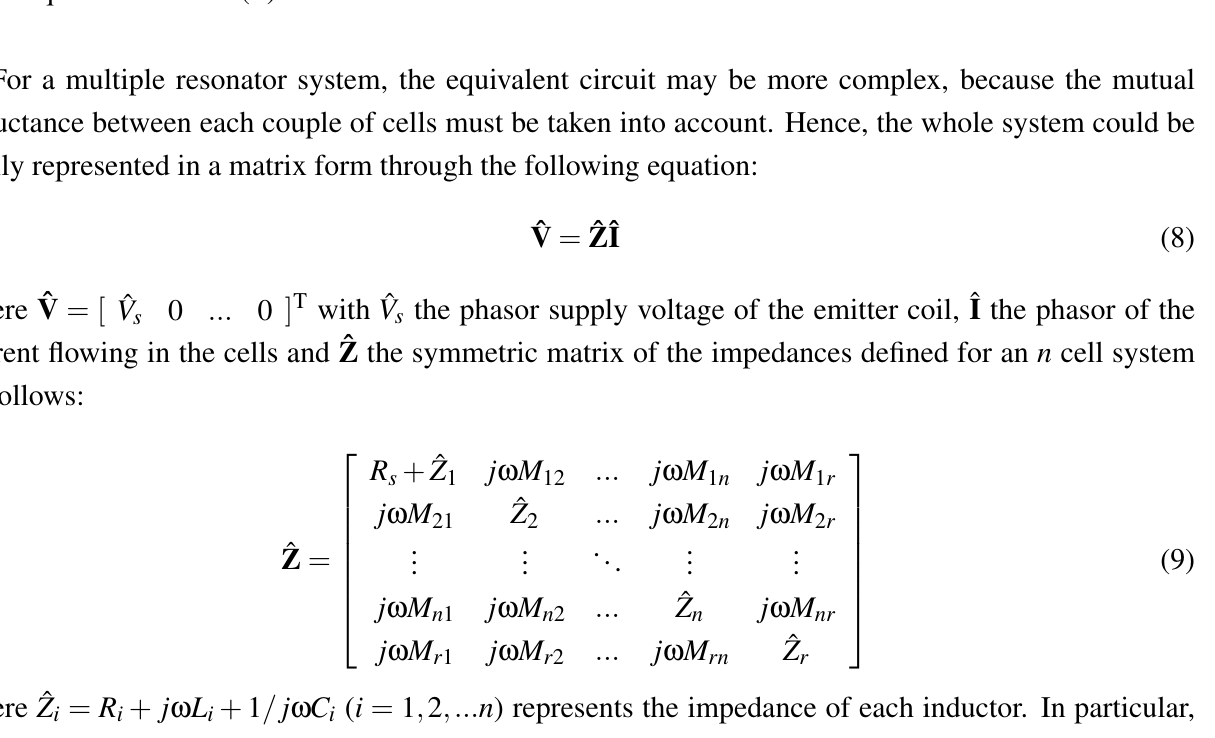
Figure 5. Example of a spiral resonator considered in this study ( a ) and its quasi-static equivalent circuit ( b